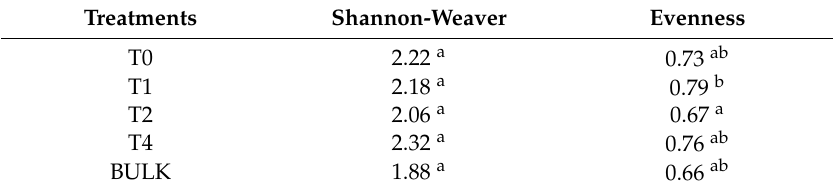
Table 4. The Shannon–Weaver diversity index and the Evenness Index between treatments sampled. Treatments